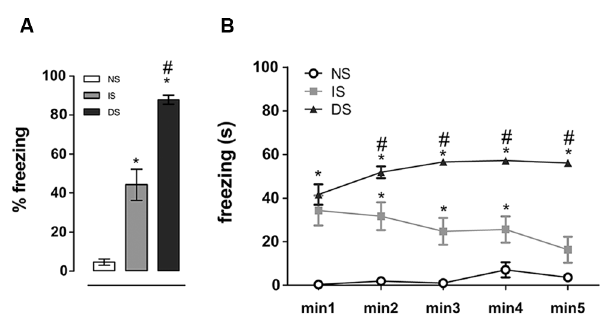
FIGURE 2 | Freezing behavior upon re-exposure to the trauma context . Total percentage (A) and freezing time expressed minute by minute of exposure time (B) . NS = no-shock group ( n = 10); IS = immediate shock group ( n = 10); DS = delayed shock group ( n = 10). * p < 0.05 compared to NS group; # p < 0.05 compared to IS group.